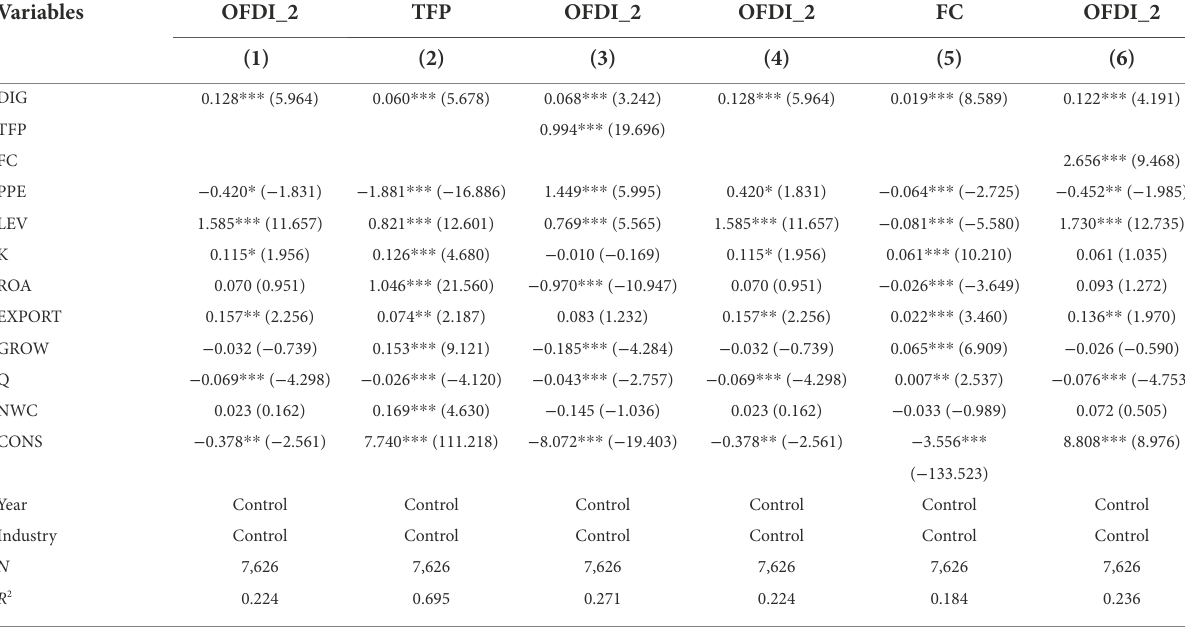
TABLE 6 Regression results of the mediating effect of total factor productivity (TFP) and financing constraint (FC).